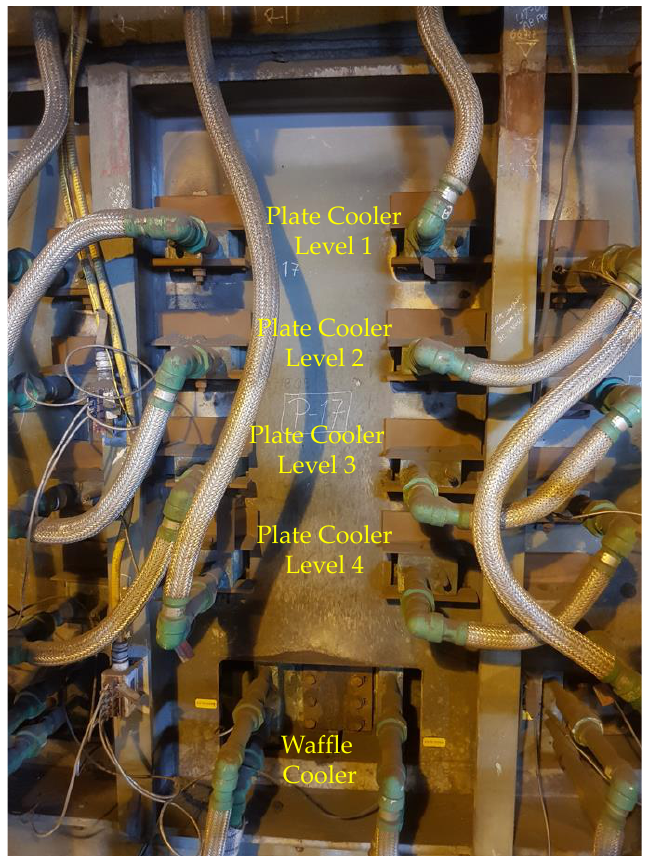
Figure 6. External view of panel #17 of the 72 panels wallside that radially compose the furnace.